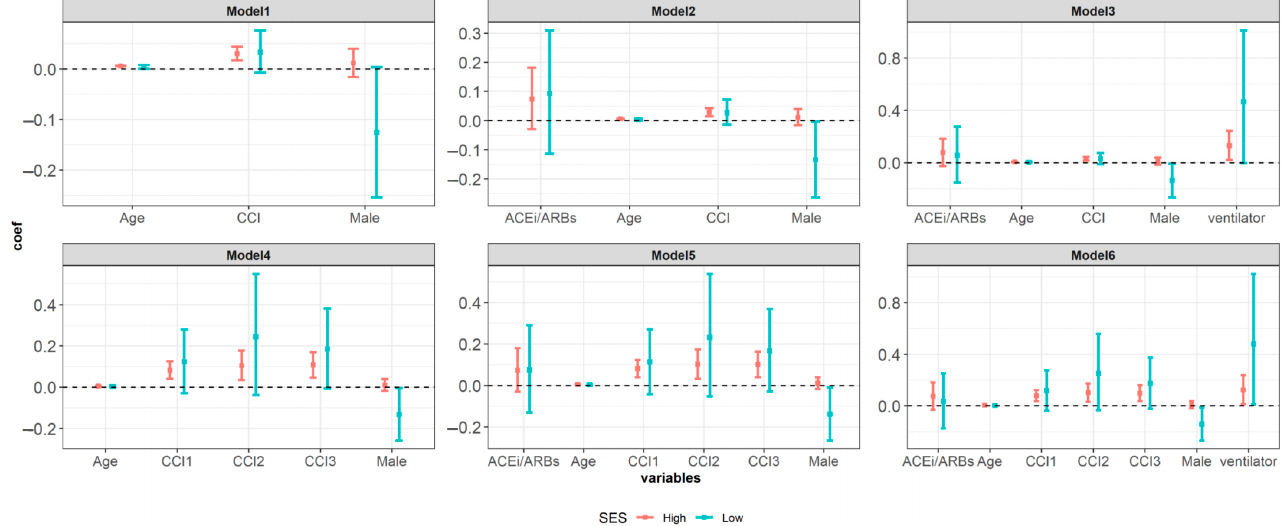
Figure 4. The effect of the Charlson Comorbidity Index and whether or not taking ACEi/ARBs in the past or present on hospital stay according to the subgroup analysis based on the variable for classifying insurance types as a substitute variable for the socioeconomic status. Note: Model1: adjusted covariates age, sex, insurance type and Charlson Comorbidity Index as continuous variables, Model2: adjusted covariates age, sex, insurance type, angiotensin converting enzyme inhibitors (ACEi) and angiotensin II receptor blockers (ARBs) and Charlson Comorbidity Index as continuous variables, Model3: adjusted covariates age, sex, insurance type, angiotensin converting enzyme inhibitors (ACEi) and angiotensin II receptor blockers (ARBs), ventilator and Charlson Comorbidity Index as continuous variables, Model4: adjusted covariates age, sex, insurance type and Charlson Comorbidity Index as categorical variables with reference CCI score0 (without underlying disease), Model5: adjusted covariates age, sex, insurance type, angiotensin converting enzyme inhibitors (ACEi) and angiotensin II receptor blockers (ARBs) and Charlson Comorbidity Index as categorical variables with reference CCI score0 (without underlying disease), Model6: adjusted covariates age, sex, insurance type, angiotensin converting enzyme inhibitors (ACEi) and angiotensin II receptor blockers (ARBs), ventilator and Charlson Comorbidity Index as categorical variables with reference CCI score is 0 (without underlying disease). CCI Charlson Comorbidity Index score; CCI1 Charlson Comorbidity Index score=1; CCI2 Charlson Comorbidity Index score=2; CCI3 Charlson Comorbidity Index score ≥ 3 .